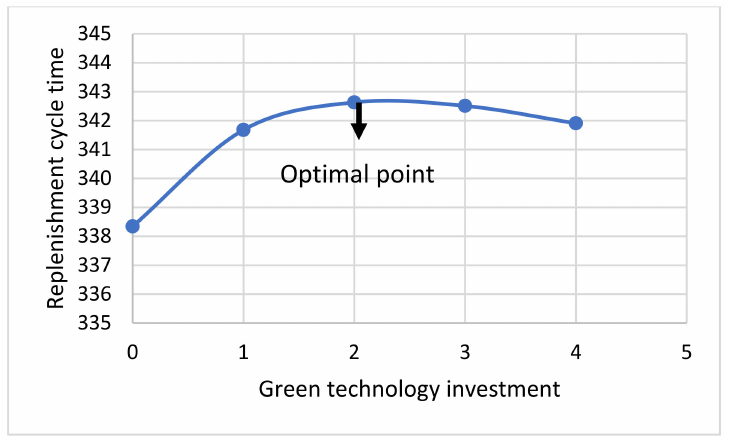
Figure 4. Impact of green technology investment on total profit when T ≤ S .